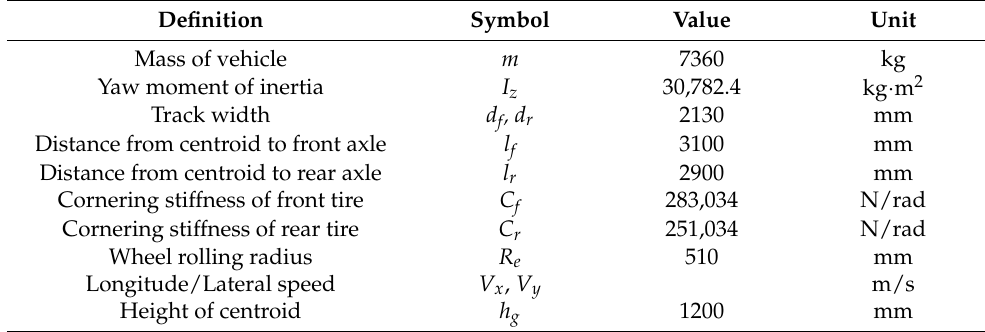
Table 1. Vehicle